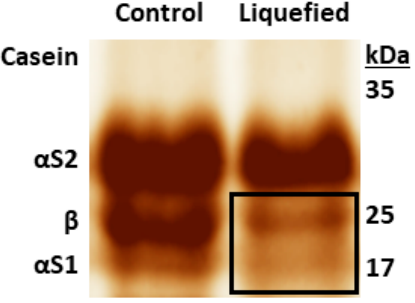
Figure 6 . Control pudding and liquefied vanilla pudding in SDS gel (silver staining). In the liquefied sample, a much weaker band of β -casein, but also of α S1-casein was detected (right lane, black in- set).